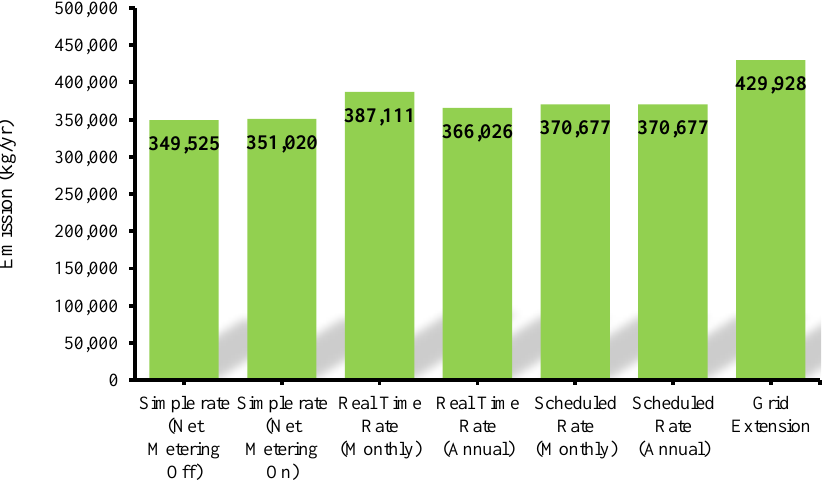
Figure 12. CO 2 emission comparison.